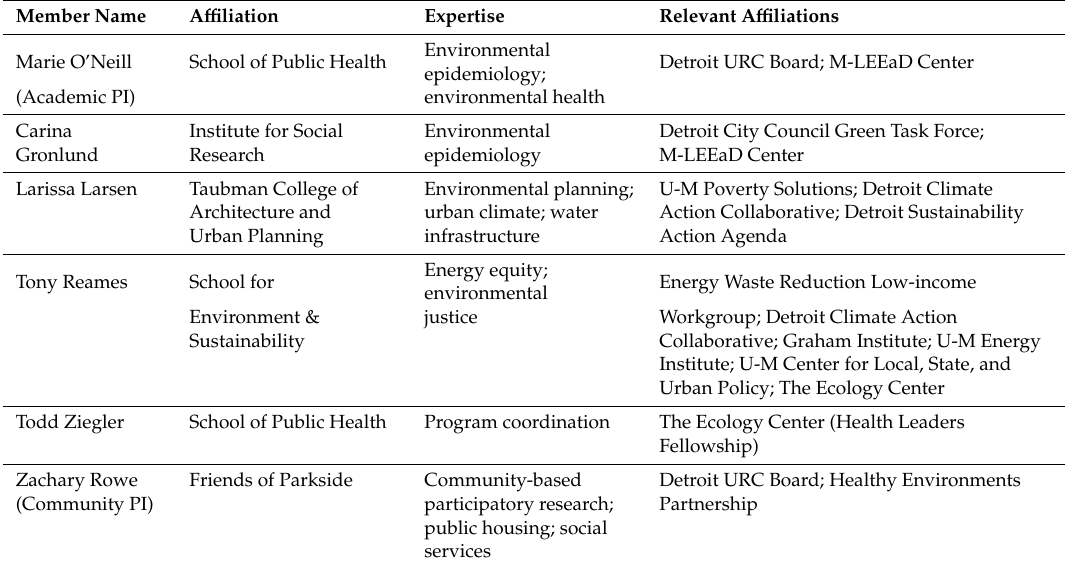
Table A1. HHH Steering Committee